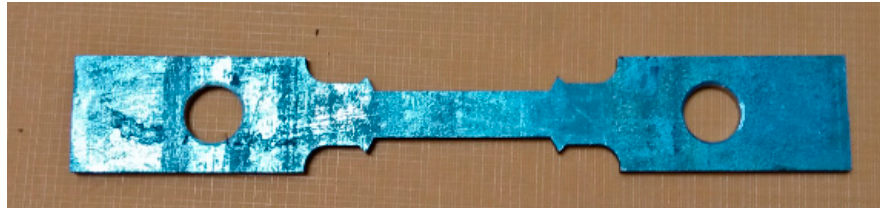
Figure 1. Example of the specimen for tensile coupon test.